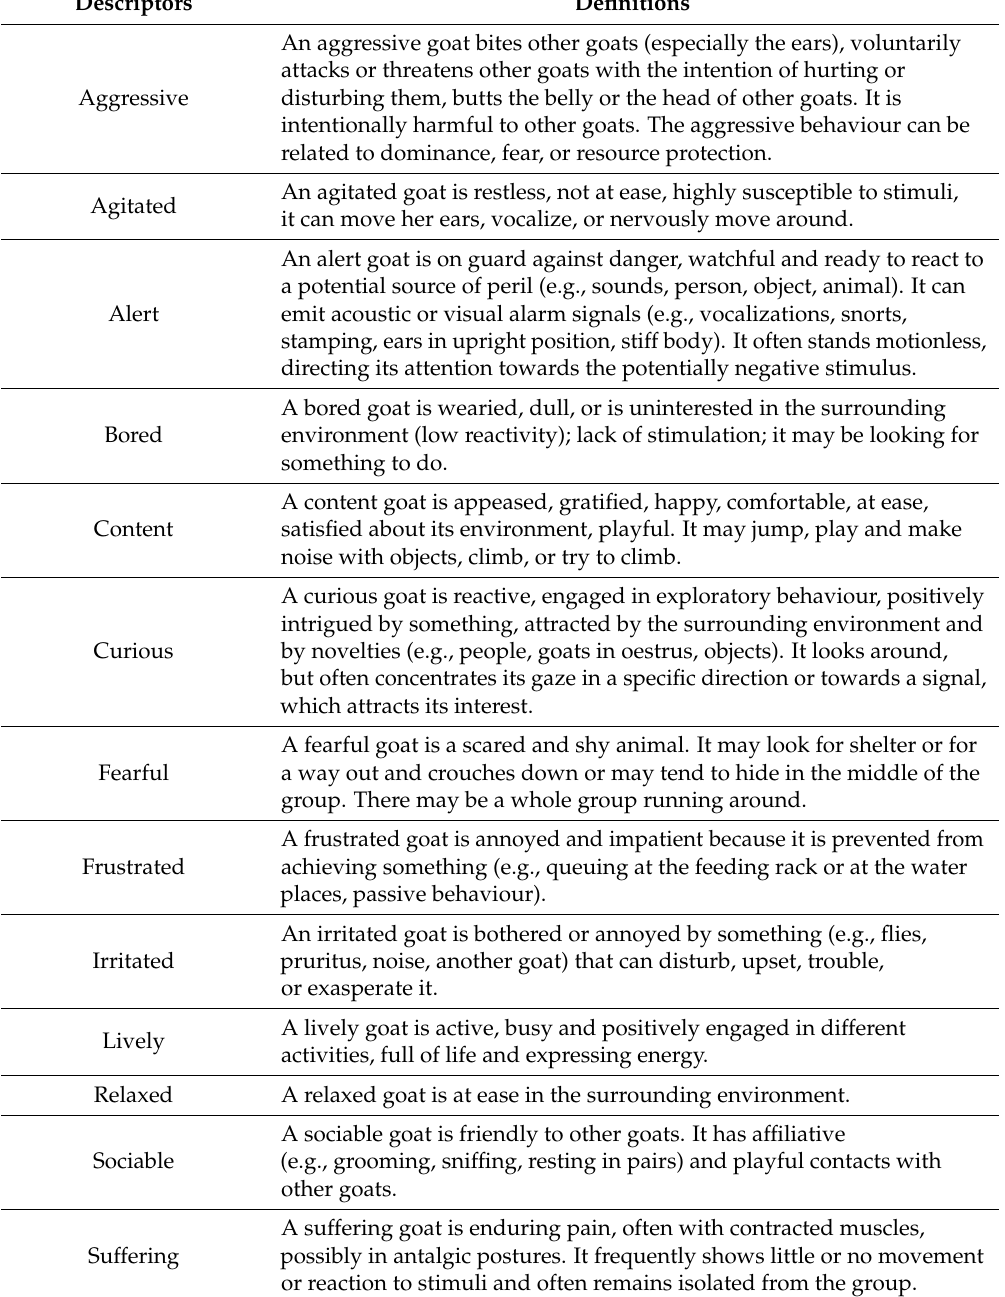
Table 2. List of Qualitative Behaviour Assessment descriptors and